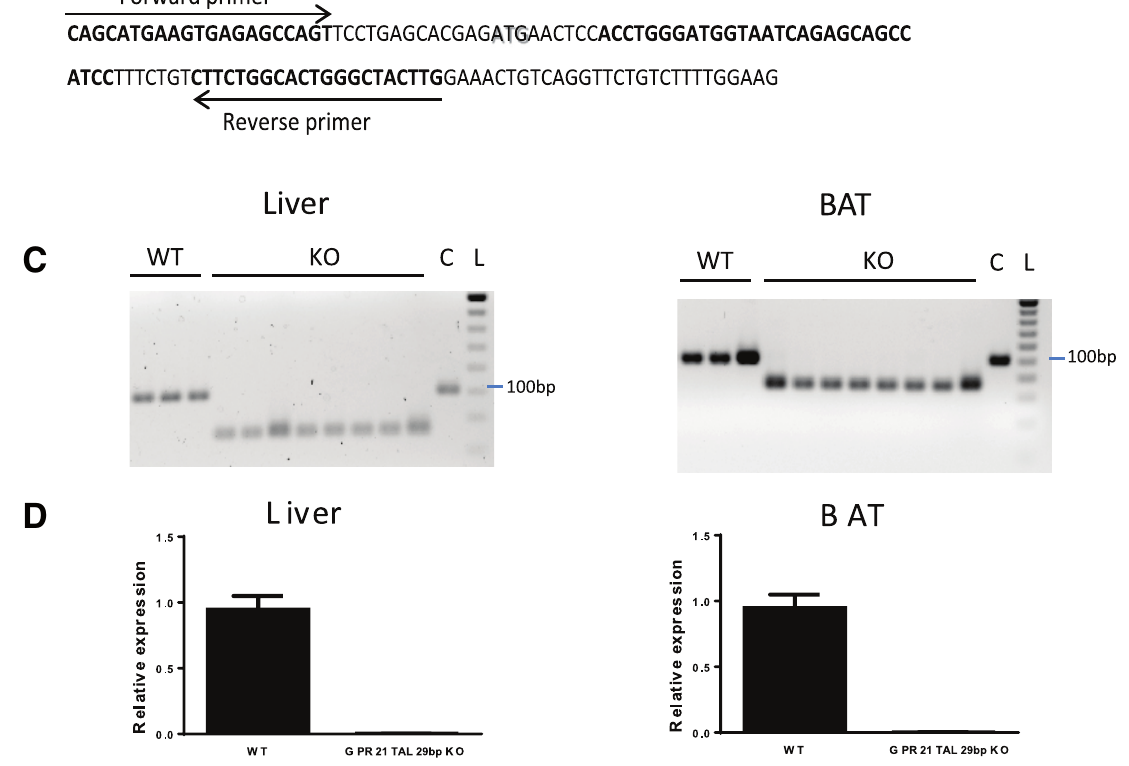
Figure 2. ( A ). Sequence and location of the 29 bp deletion in Gpr21 TAL 29bp KO mice. ( B ). sequence and location of genotyping primers. ( C ). Genotyping of Gpr21 TAL 29bp KO mice. Genomic DNA was generated from liver and BAT. PCR with genotyping primers amplified a 100 bp fragment from the genome of WT littermate mice and a 71 bp fragment from homozygous Gpr21 TAL 29bp KO mice. C: commercial mouse genomic DNA. L: 20 bp DNA ladder. ( D ). No wildtype Gpr21 transcript were detected. qPCR analysis of Gpr21 gene in liver and BAT using primer/probe set that located in the 29 bp region and only detect wildtype Gpr21 transcript.